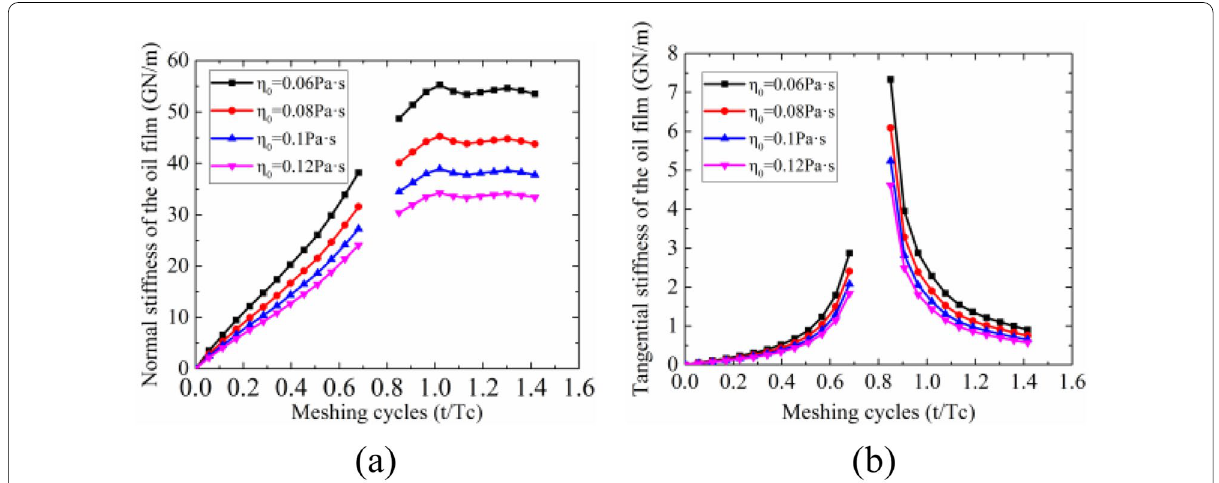
Figure 15 Influence of the initial lubrication